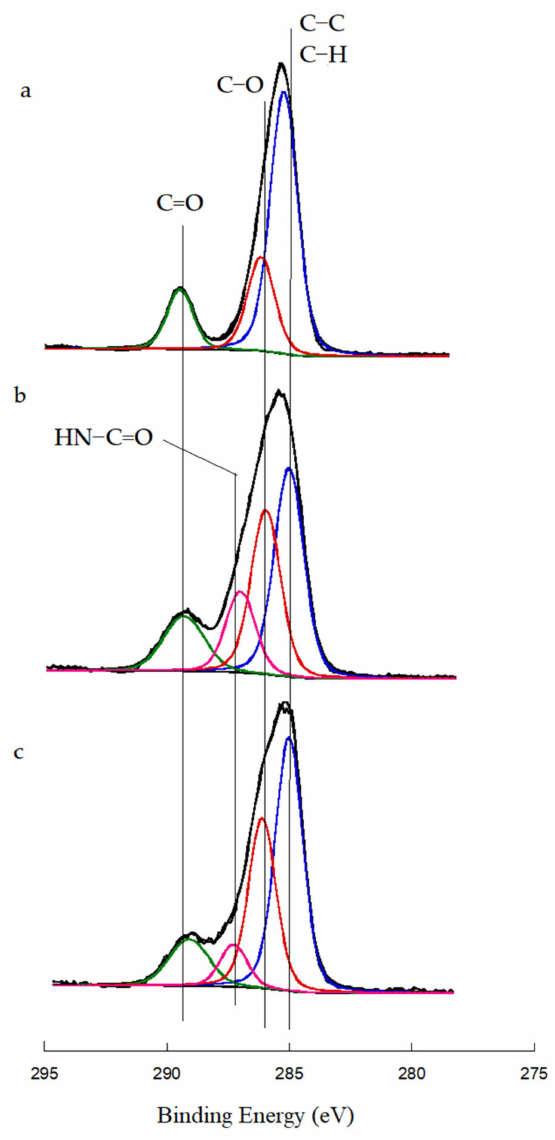
Figure 6. C 1s core level normalized spectra of PMAA 2 ( a ), PMAA-G 3.0 -CNTs 3 ( b ), and PMAA-G 3.0 - CNTs 4 ( c